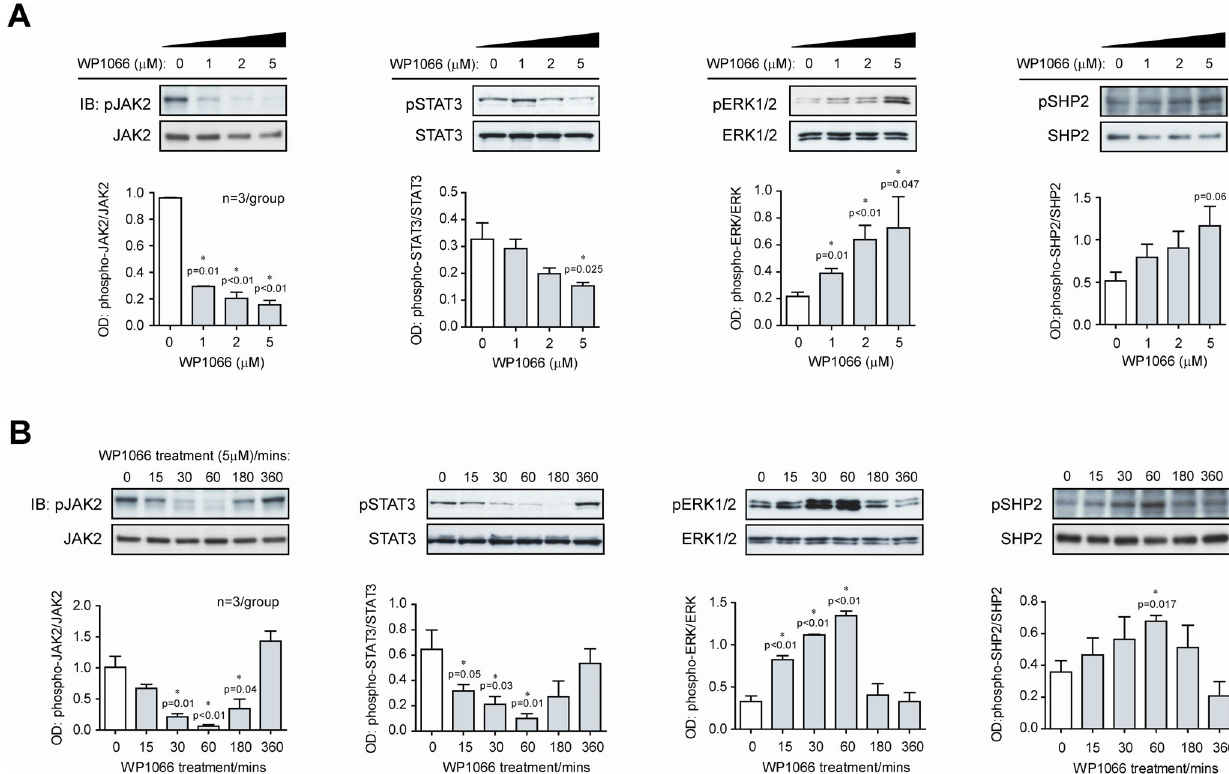
Figure 1. WP1066 modulates STAT3 and MAPK signalling endpoints in AGS cells. A. Dose-response: AGS cells were treated with WP1066 at 0, 1, 2 and 5 m M for 60 min and extracts immunoblotted with antibodies specific for (i) pJAK2 and JAK2; (ii) pSTAT3 and STAT3; (iii) pERK1/2 and ERK1/2; (iv) pSHP2 and SHP2. Data was also expressed as a ratio of the phosphorylated to total protein product in each case. The outcomes of 3 experiments are shown as mean OD ratios 6 standard error (SE). Statistical significance for each treatment compared to 0 m M WP1066 is shown if p , 0.05. B. Time-course: AGS cells were treated as in Fig. 1A but with 5 m M WP1066 for 0, 15, 30, 60, and 180 min. Data was treated as for Fig. 1A. doi:10.1371/journal.pone.0095993.g001 PLOS ONE |